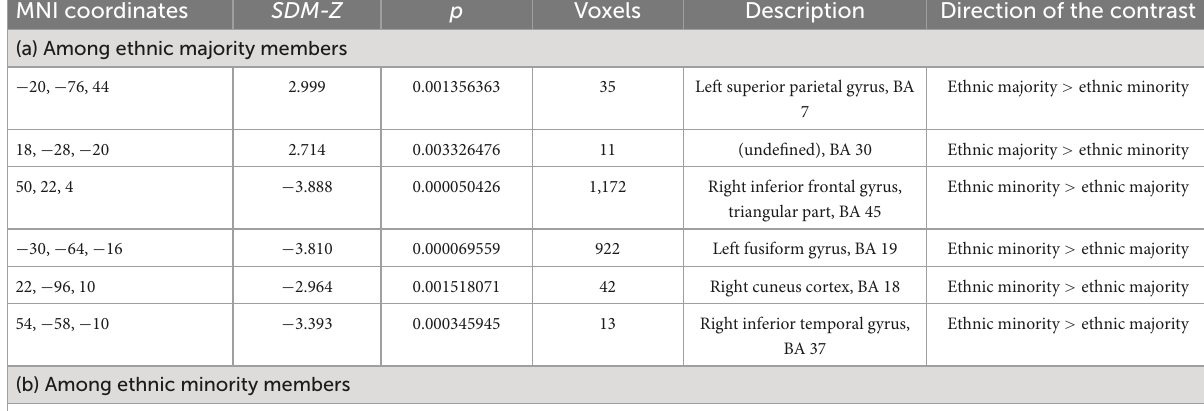
TABLE 1 Neural inter-group bias toward ethnic minority vs. majority members (a) among ethnic majority members and (b) among ethnic minority members. MNI coordinates SDM-Z p Voxels Description Direction of the contrast